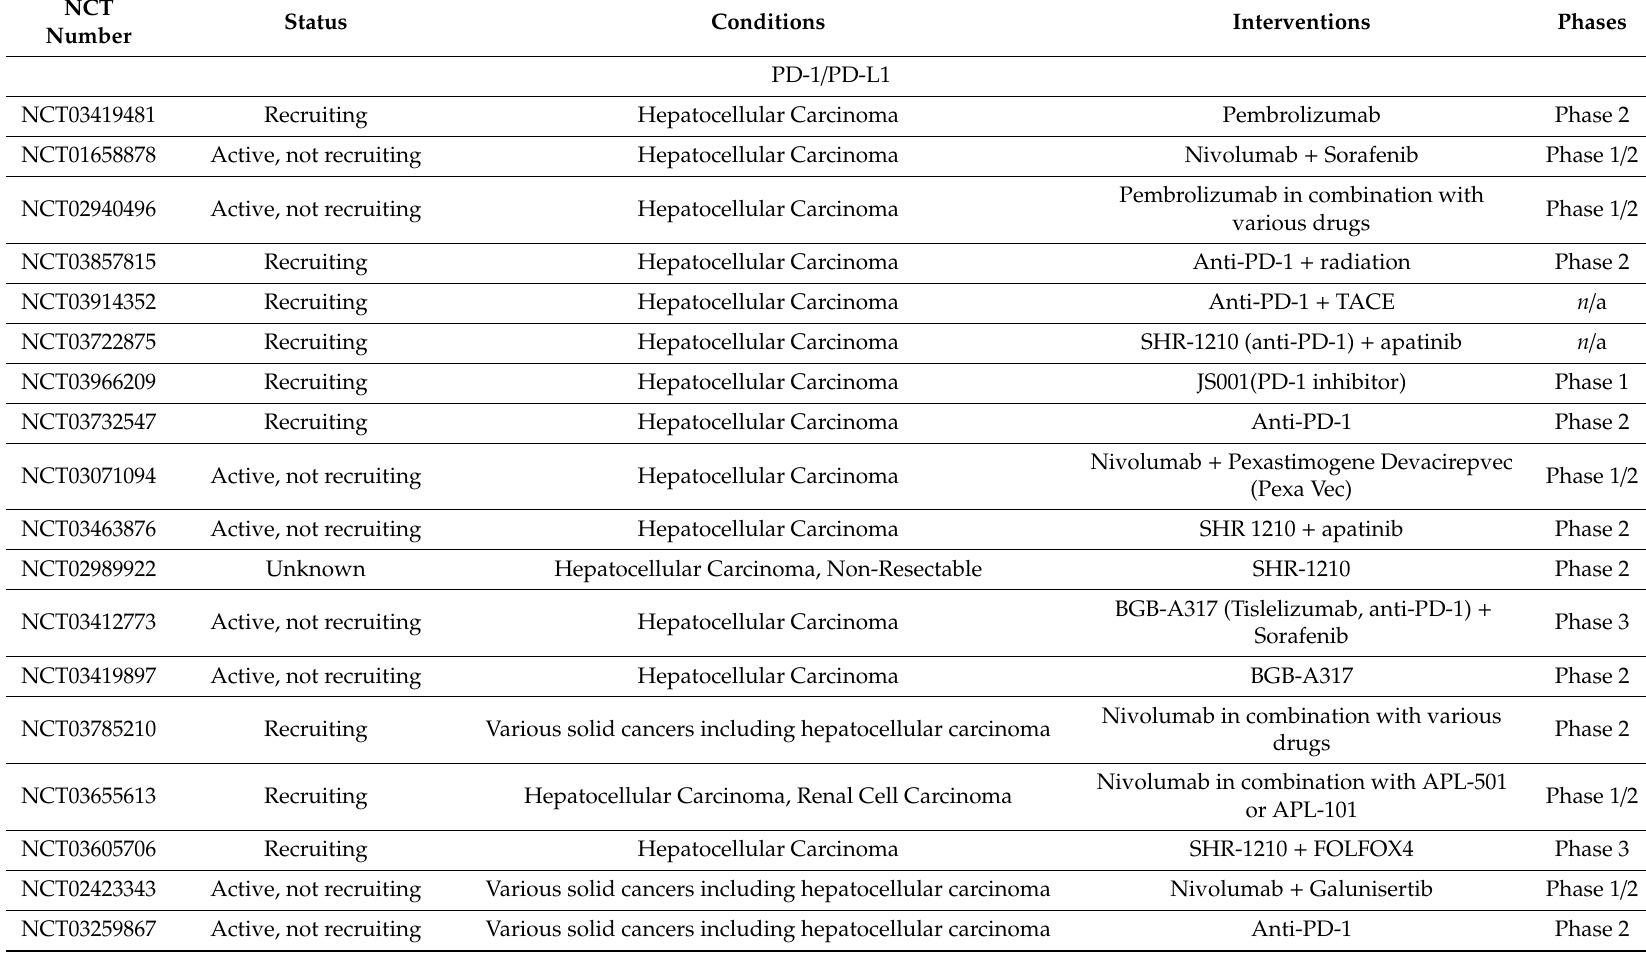
Table 2. Ongoing clinical trials evaluating immunotherapeutics in advanced